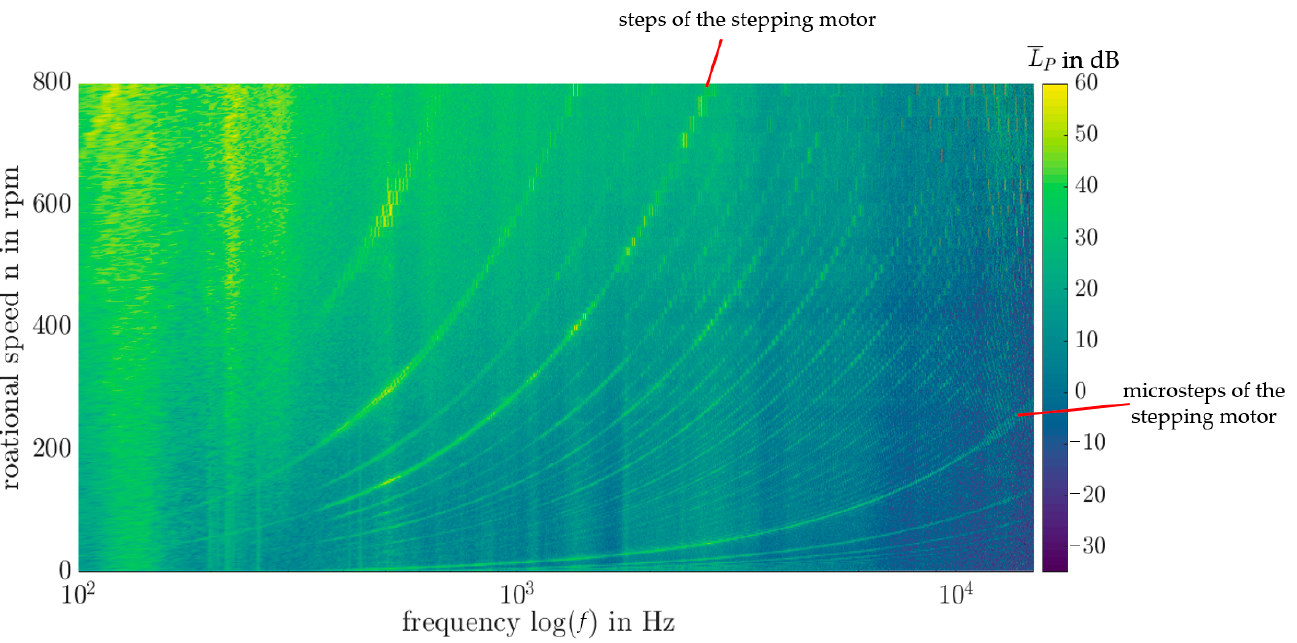
Figure 9. Campbell-plot of the self-induced noise of the active turbulence grid.